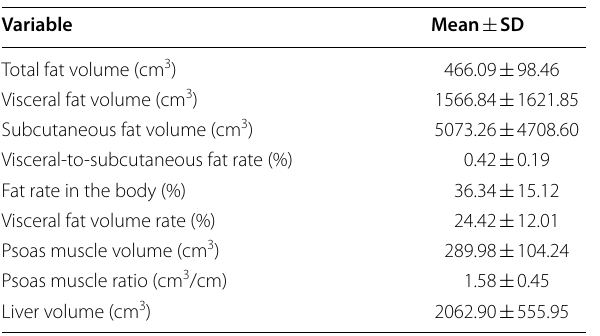
Table 5 Visceral and subcutaneous fat, psoas muscle mass, and liver volume based on fatty liver’s grade